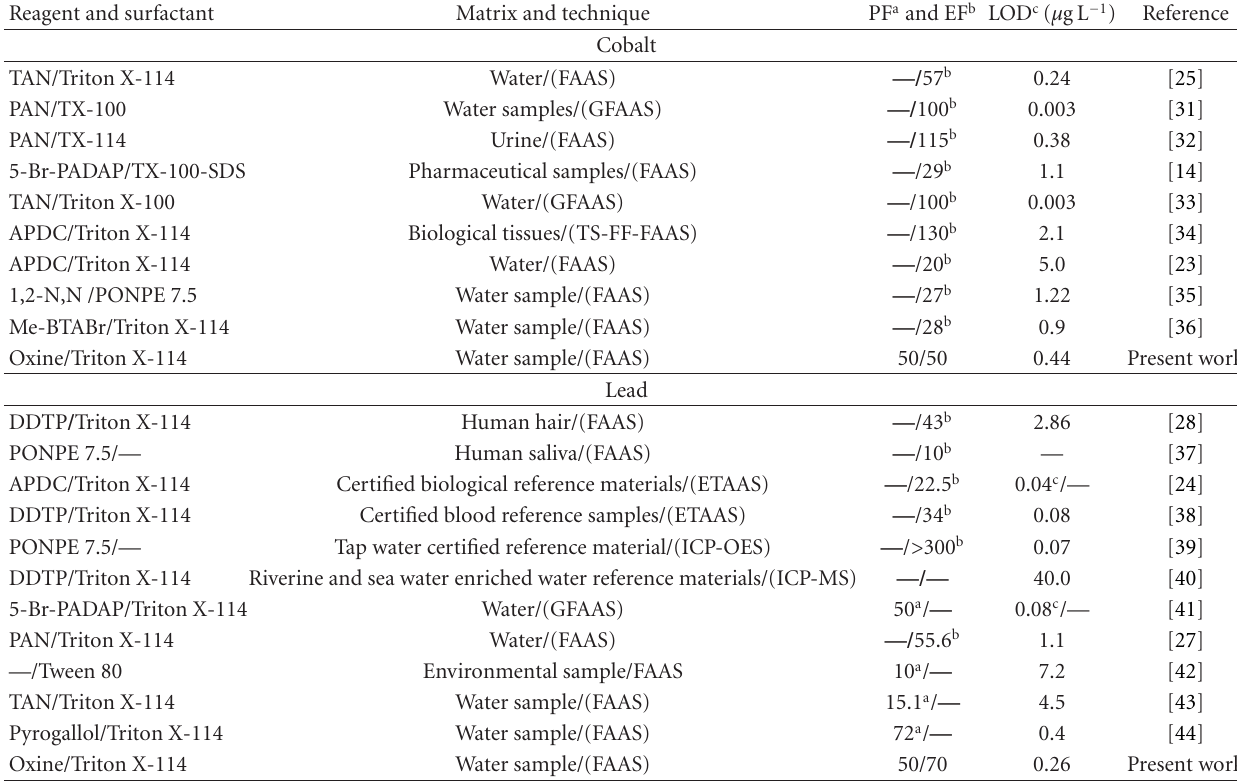
Table 5: Comparative table for determination of cobalt and lead in di ff erent types of samples applying CPE before analysis by atomic spectrometric